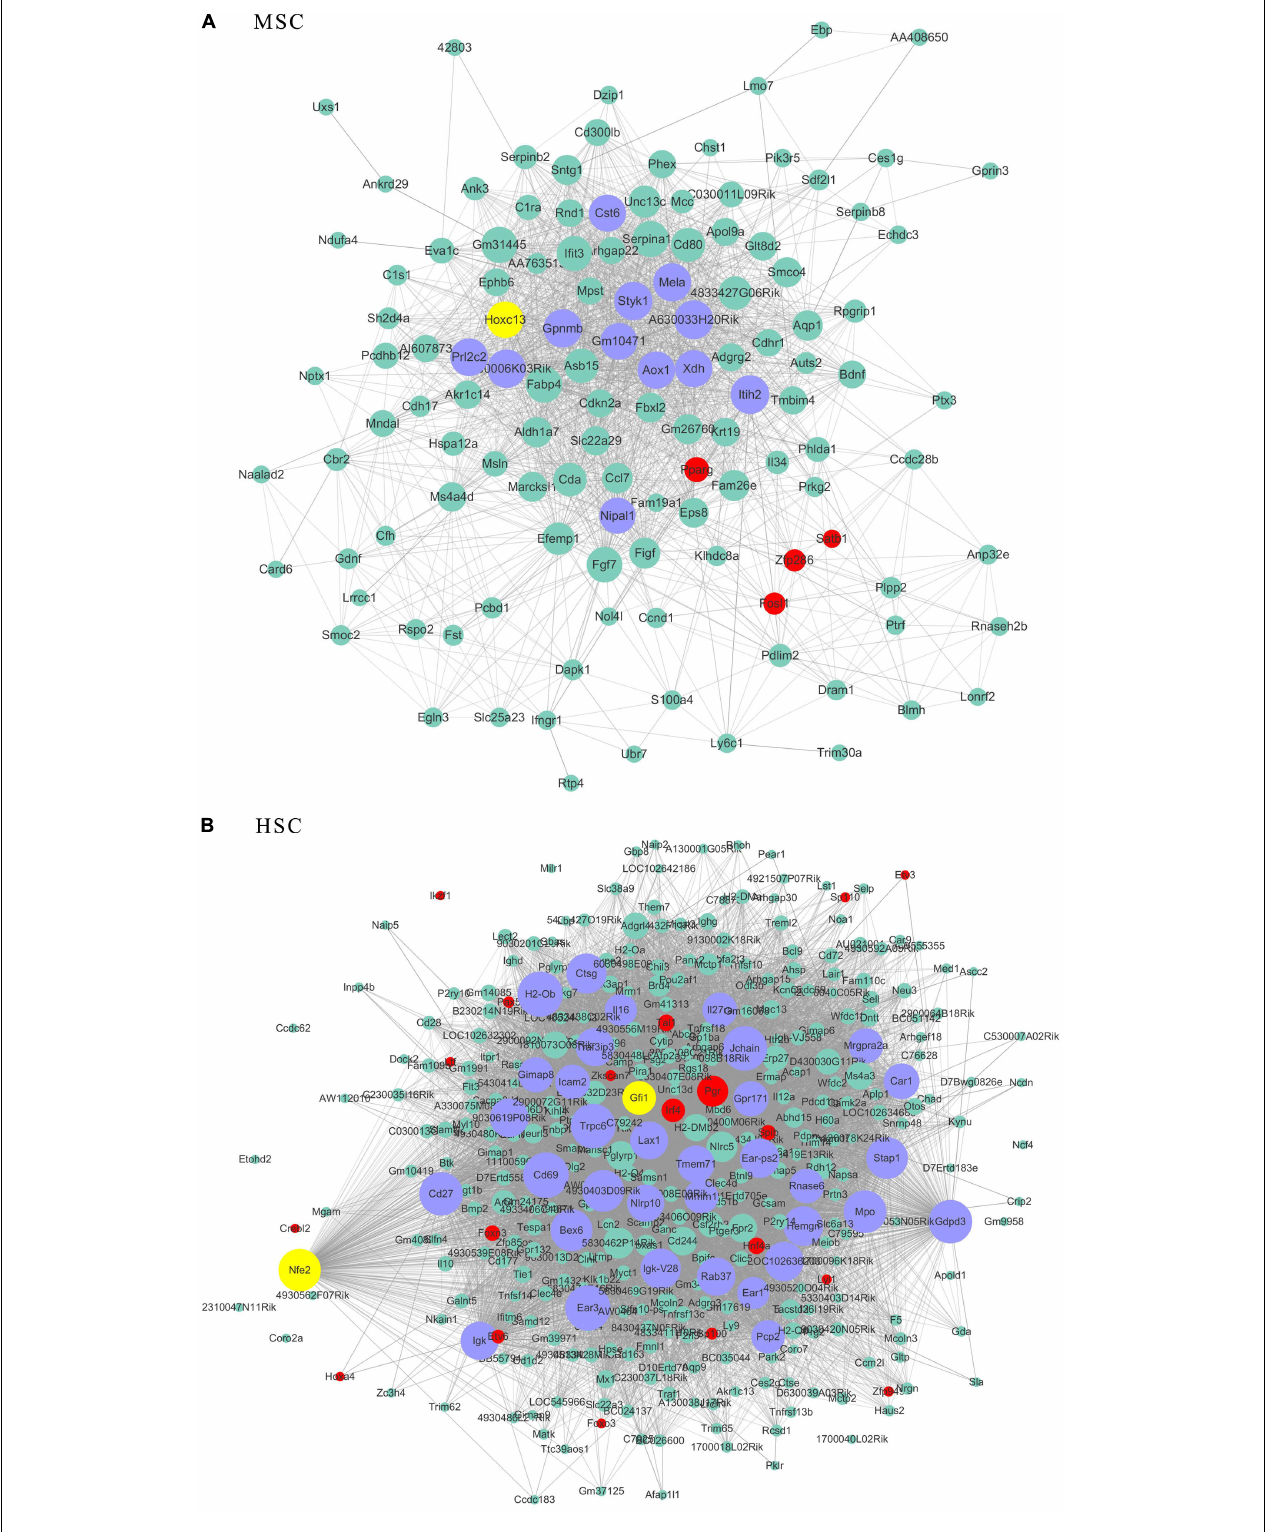
FIGURE 6 | The related co-expression networks of SSC and NSC. MSC-correlated pink module (A) and HSC-correlated blue module (B) . The hub nodes are highlighted in blue within the co-expression networks. Transcription factors within the respective network are highlighted in red. Transcription factors that were included in the top 10% of nodes are highlighted in yellow within the respective networks. The size of the nodes corresponds to their degrees.